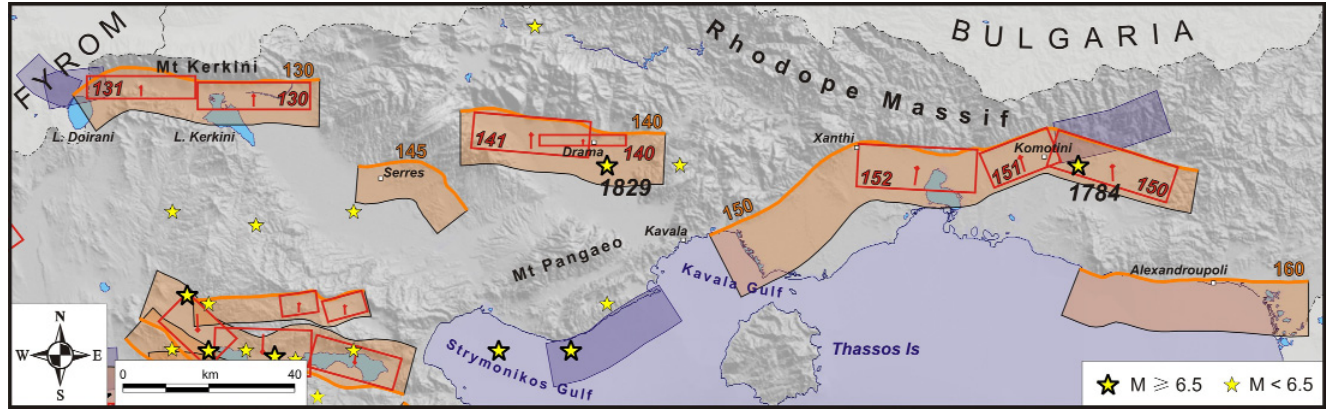
Figure 3. Map detail of the seismogenic sources belonging to the "Northern Greece fault belt". See Figure 1 for map location and seismogenic sources. Three-digit labels refer to the database code of the seismogenic source (ISS codes in italics). Years are provided for major earthquakes discussed in the main text (see also Table